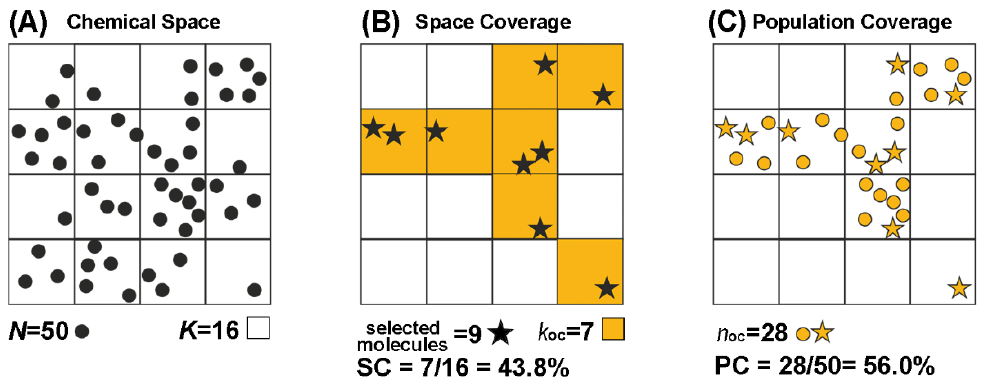
Figure 5. Considering the selection of 9 compounds among a database consisting of 50 molecules ( N = 50, represented as dots). ( A ) After applying a clustering or partition-based method, the chemical space is divided into 16 partitions (clusters or occupied bins, K = 16). ( B ) If the 9 selected compounds (depicted as stars) are distributed in 7 clusters ( k oc = 7, in orange), this corresponds to 43.8% SC. ( C ) Moreover, in these colored clusters are involved 28 samples of the database ( n oc ). Hence, the 7 selected molecules are representative of 28 out of the 50 compounds included in the database, which represents 56.0%